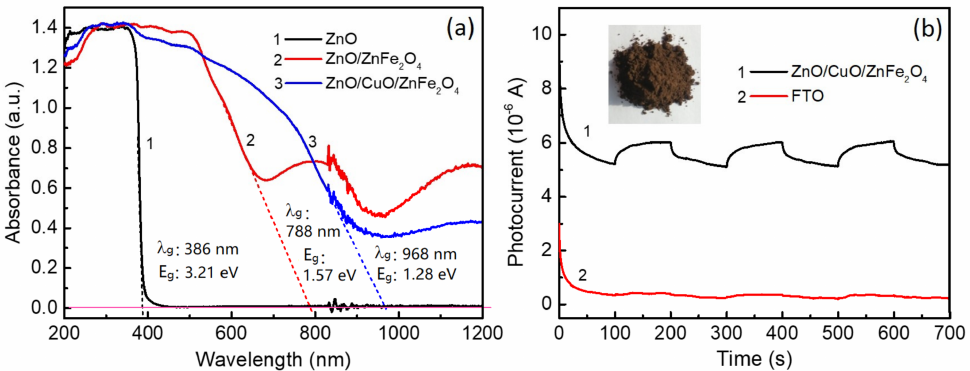
( a ) UV-vis-NIR diffuse reflectance spectra (DRS) for ZnO, ZnO/ZnFe 2 O 4 and the ZnO/CuO/ZnFe 2 O 4 nanocomposite; ( b ) photocurrent generation for the ZnO/CuO/ZnFe 2 O